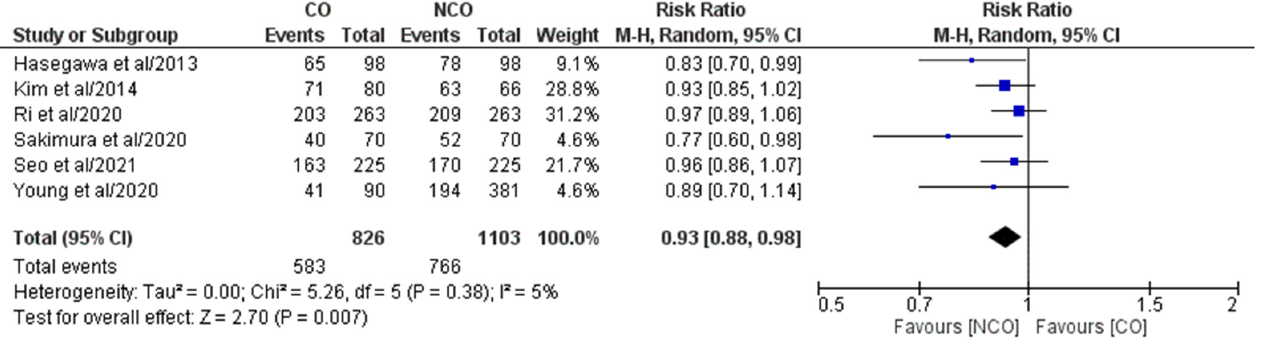
Figure 3. Forest plot comparing 5-year OS between the CO and NCO groups. CI, confidence inter- val; M–H, Mantel–Haenszel [16–21].